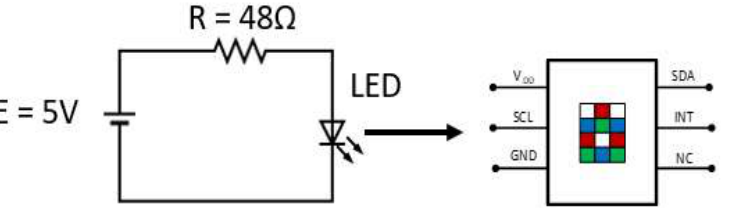
Figure 7. Instrument configuration used for characterization of source radiation. Left side is a schematic diagram of the RGB LED green channel; right side is a representation of the RGBC TCS34725 photodiode.